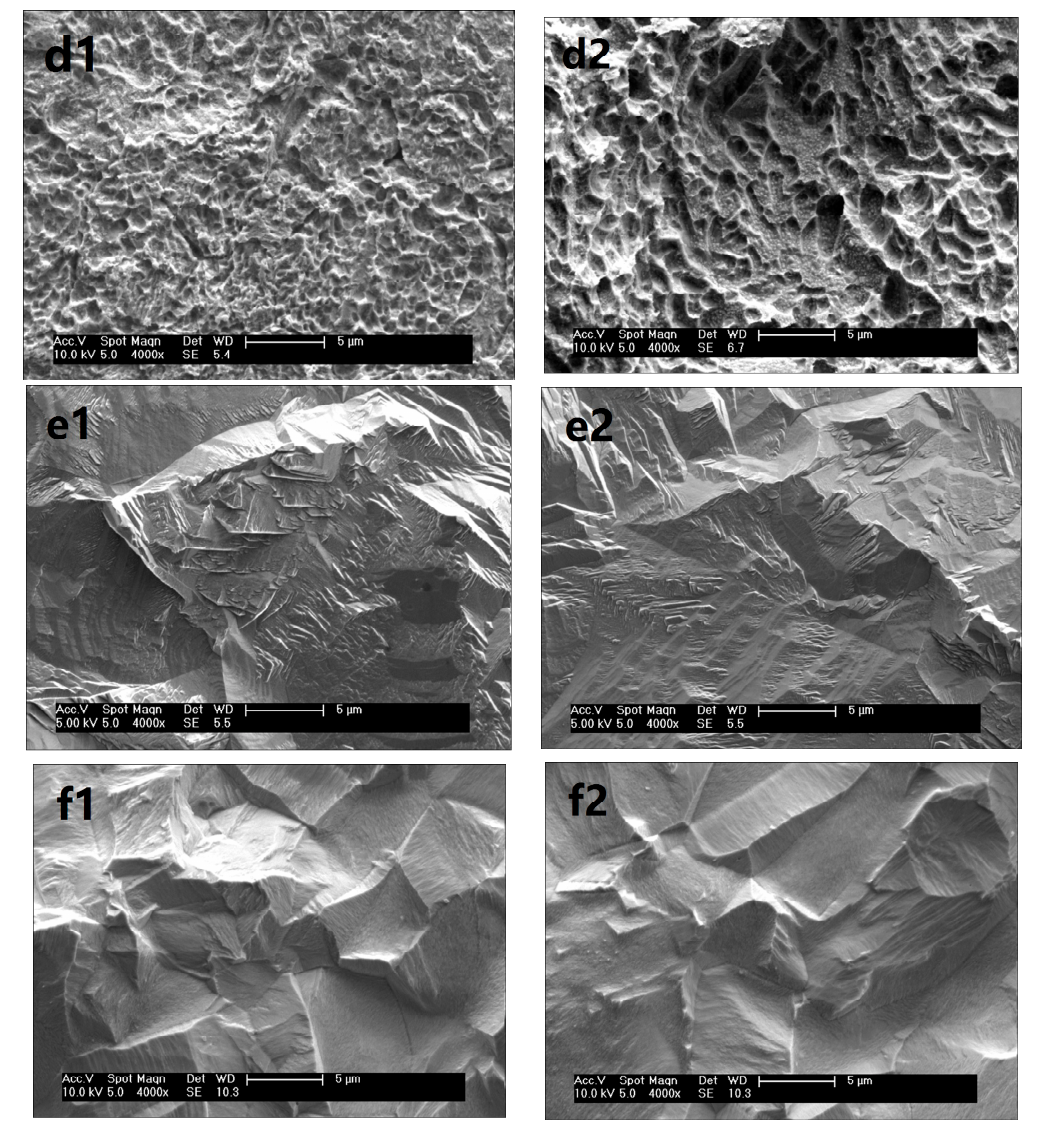
Figure 7. SEM images of Ni surfaces: ( a ) untreated; ( b ) etched by 10.2 wt% HCl for 42 h and 56 h; ( c ) etched by 10.1 wt% H 2 SO 4 for 42 h and 49 h; ( d ) etched by 10.0 wt% H 3 PO 4 for 56 h and 63 h; ( e ) etched by 10.1 wt% HNO 3 for 56 h and 63 h; and ( f ) etched by 40.0 wt% HF for 28 h and 35 h.